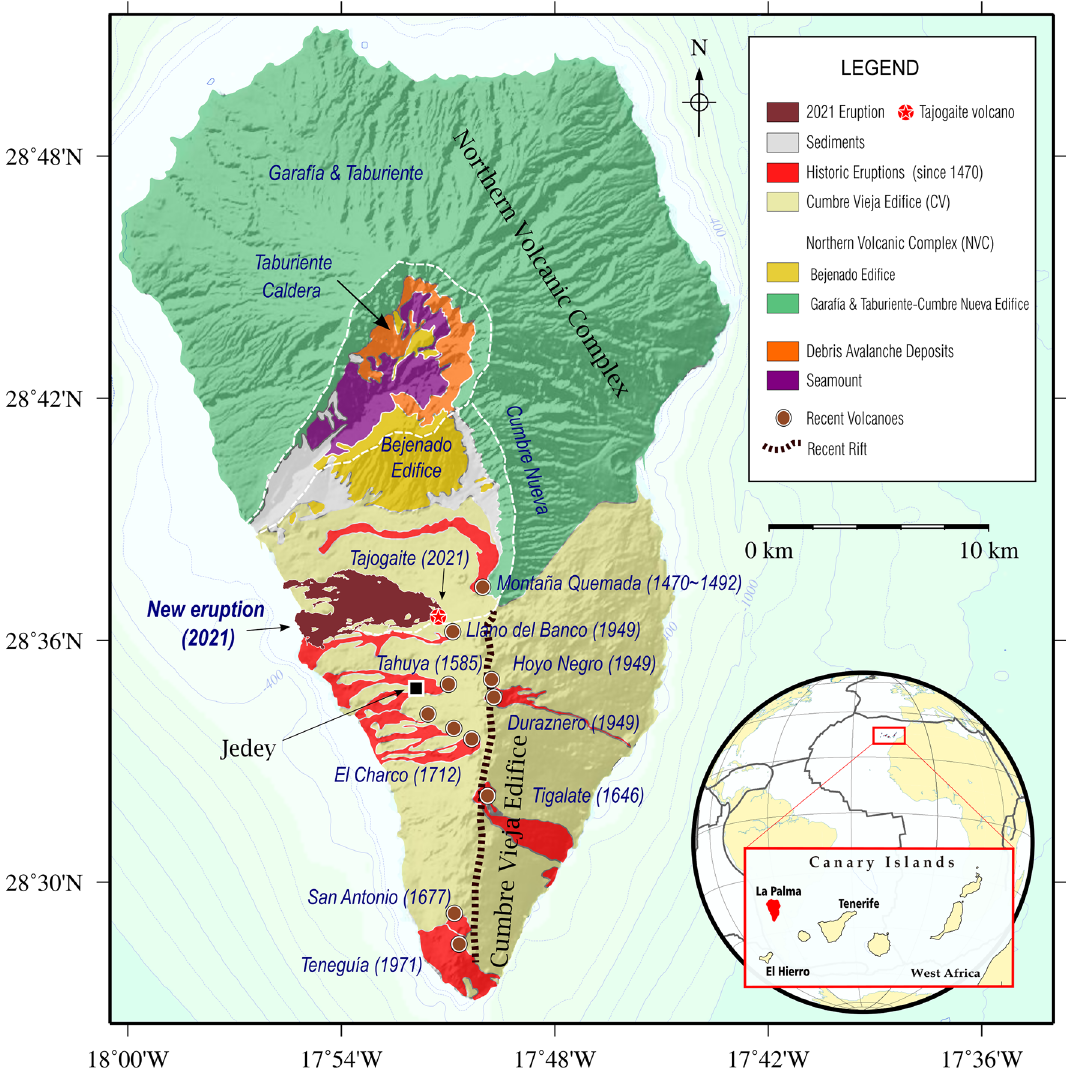
Figure 1. Geographical location and geological and volcanological elements of La Palma island. Geologic elements of La Palma showing the main volcanic complexes, ridges as well as the last historical eruptions on the Island. Upper insets show the scale and keys description. The lower inset shows the location of Canary Islands and La Palma island. GMT software (www. gener ic- maping- tools. org) was used to create this